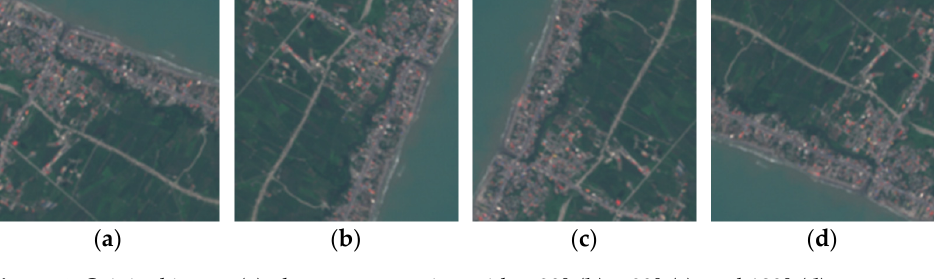
Figure 4. original image ( a ); data augmentation with ‐ 90° ( b ), +90° ( c ), and 180° ( d